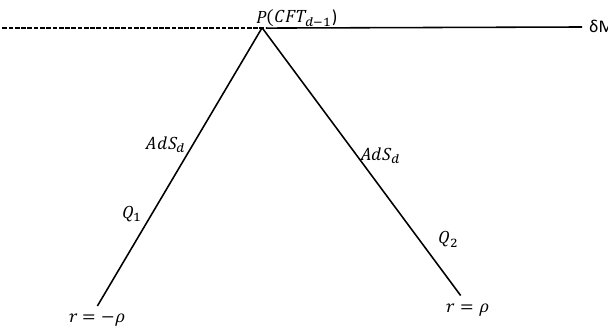
Figure 1 . Description of wedge holography. Two d -dimensional Karch-Randall branes joined at the ( d − 1) dimensional defect, Karch-Randall branes are embedded in ( d + 1) -dimensional